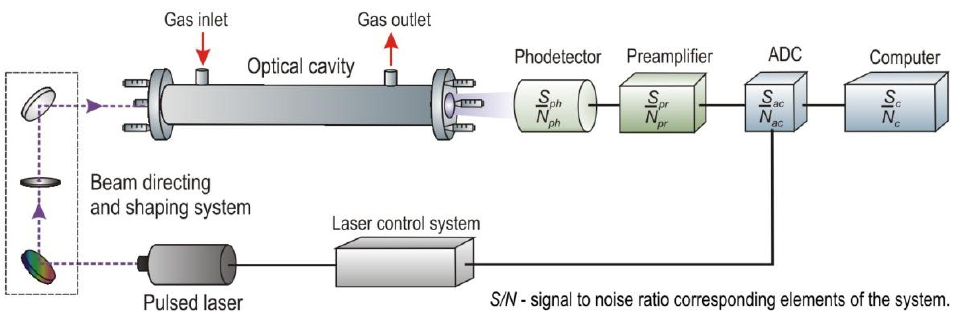
Figure 7. Block diagram of NO